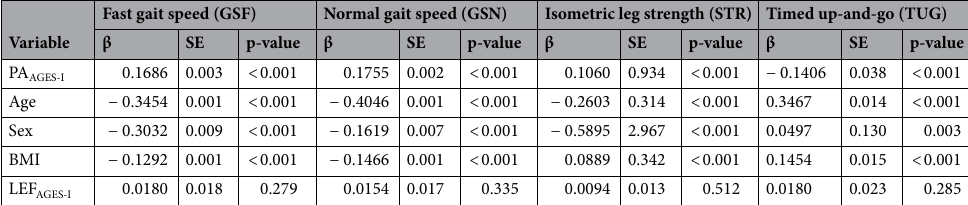
Table 2. Multivariate multiple regression models of the relationship between PA AGES-I and LEF AGES-II . All four PA AGES-I hypothesis tests surpassed their respective thresholds for Holm–Bonferroni (HB)